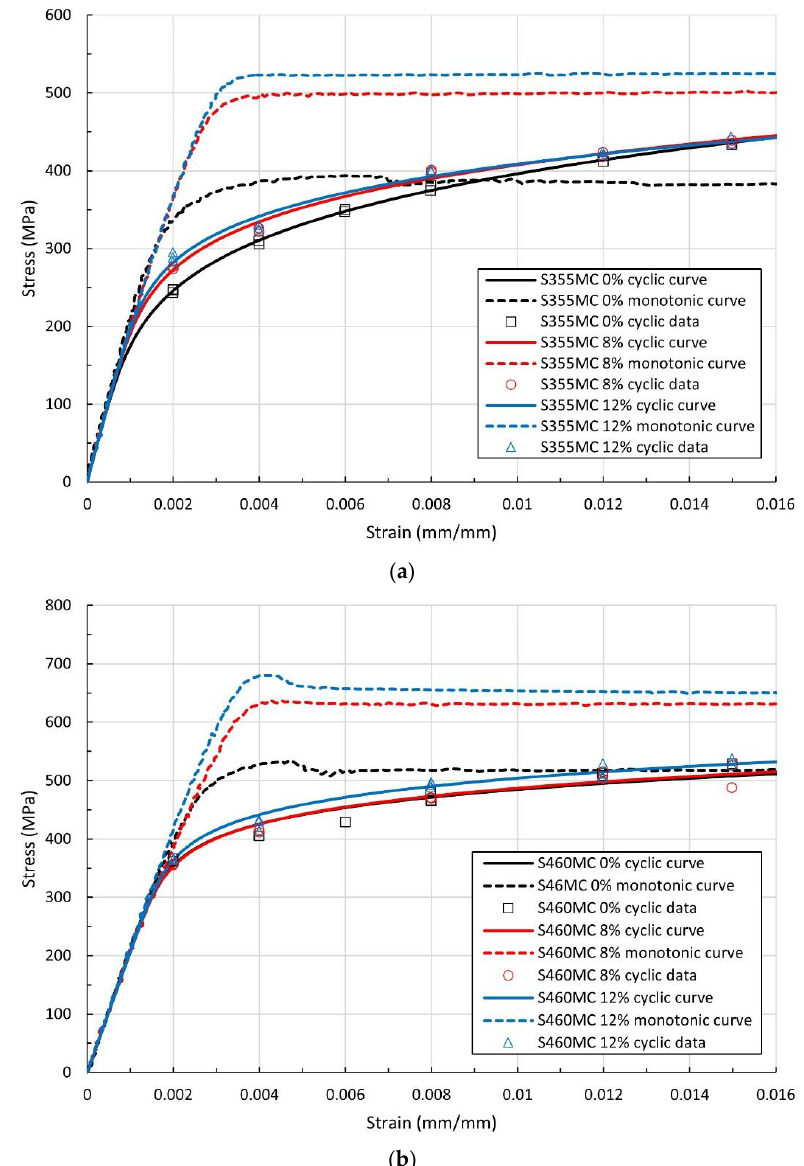
Figure 5. Comparison of monotonic and cyclic σ - ε curves of ( a ) S355MC and ( b ) S460MC steel. By comparing the cyclic stress – strain curves with the respective monotonic curves from Figure 5, cyclic softening is the predominant mechanism in the pre-strained materi- als. This is caused by dynamic recovery processes, mostly cross slip, with which disloca- tion glide may proceed at lower flow stresses. Pre-staining intensifies this cyclic softening behavior. The decrease in cyclic yield strength (σ yc ) compared to the monotonic value (σ y ), due to cyclic softening, reaches values of 31.2% and 33.4% for 8 % and 12% pre-straining conditions, respectively, for the S355MC steel. In the S460MC steel, the respective reduc- tion is 28.7% and 29.1%. In reference conditions, the materials exhibit a mixed type of cyclic behavior, including cyclic softening, at strain amplitudes up to 0.008 and 0.012 for